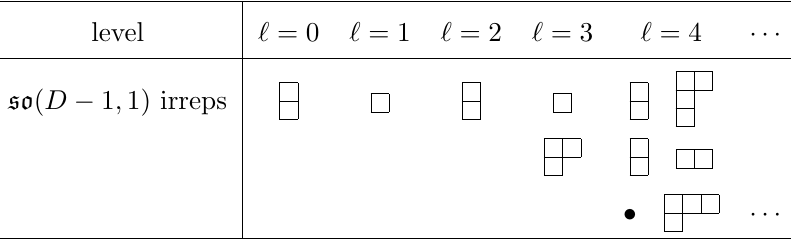
Table 1 . The Young tableaux of irreducible Lorentz representations that appear at the lowest levels 0 (cid:20) ‘ (cid:20) 4 of Maxwell 1 . The (cid:15) represents the trivial representation of the Lorentz algebra, and the tableaux represent fully traceless